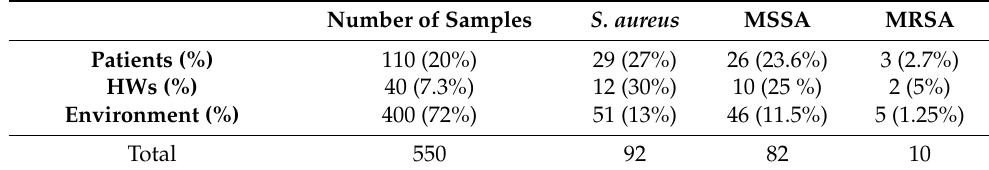
Table 1. Prevalence of S. aureus strains by number of samples, resistance phenotype and origin. Number of Samples S.